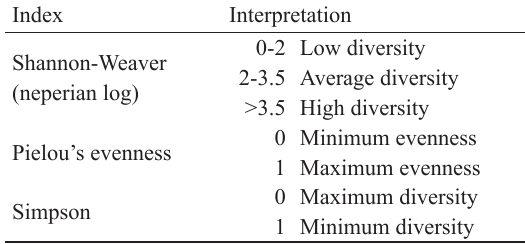
Table 3. Interpretation of indices